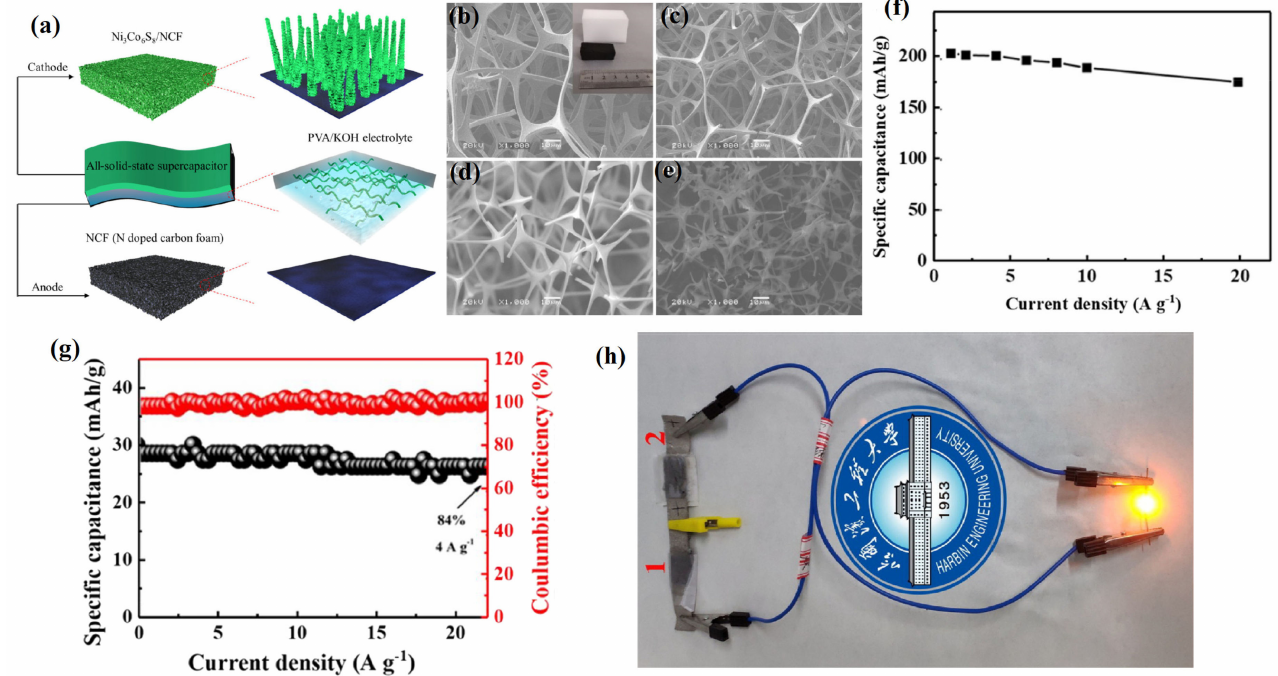
Figure 21. ( a ) Material preparation process and assembly of SCs. SEM images of ( b ) melamine sponge, ( c ) NCF carbonized for 2 h at 800 ◦ C, ( d ) 900 ◦ C, and ( e ) 1000 ◦ C. ( f ) Specific capacitance vs. current density curve. ( g ) Coulombic efficiency and cycling performance of ASC. ( h ) Using the two all-solid-state ASC in series to light LED lamps. Adapted with permission [367]. Copyright (2020) John Wiley and